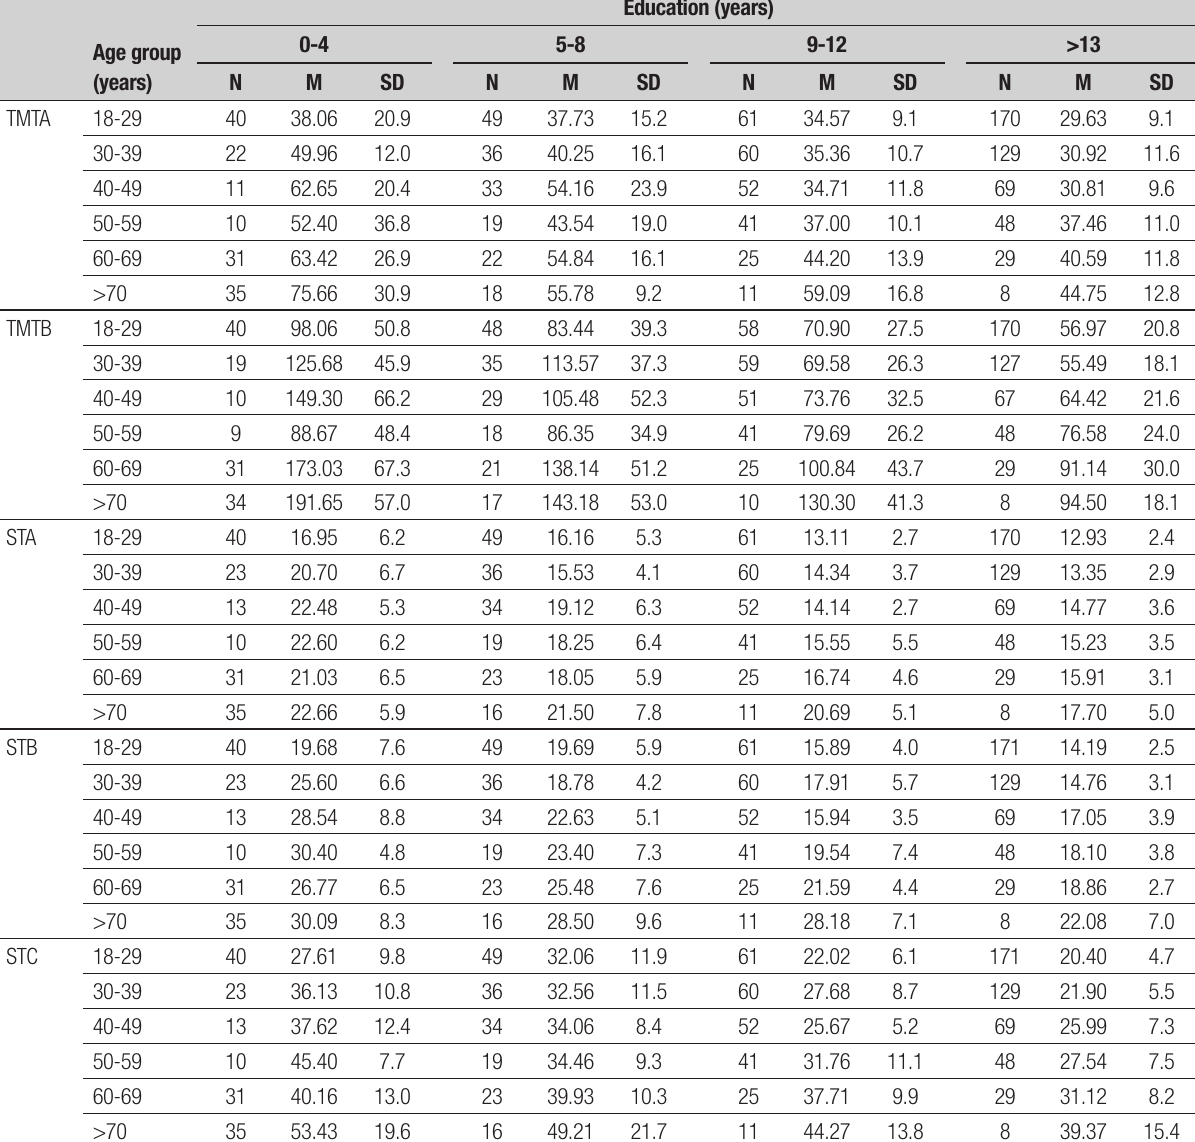
Table 3. Means and Standard Deviation for TMT and ST scores (seconds) according to age and years of education.